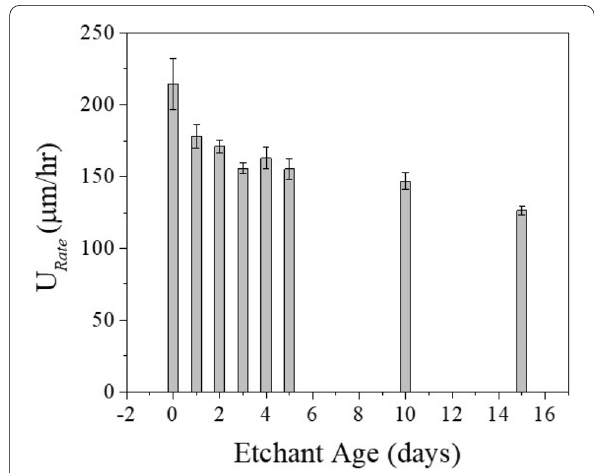
Fig. 5 Effect of etchant age on the undercutting rate in 10 M NaOH 12% NH 2 OH at convex corners +